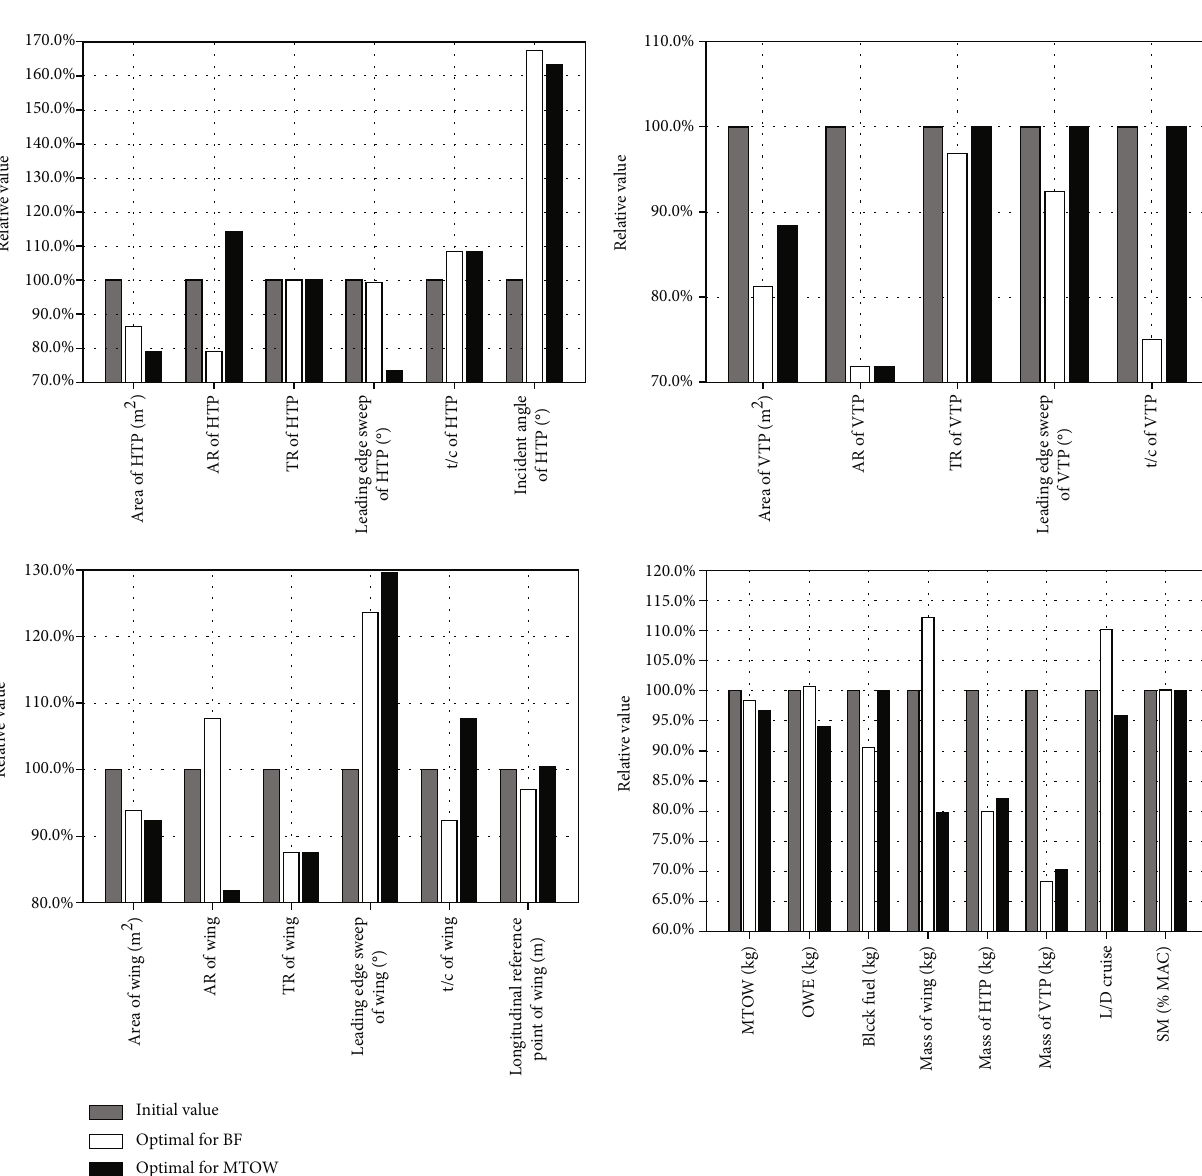
Figure 4: Relative changes of design variables, design constraints, and design objectives for HTP-VTP-wing